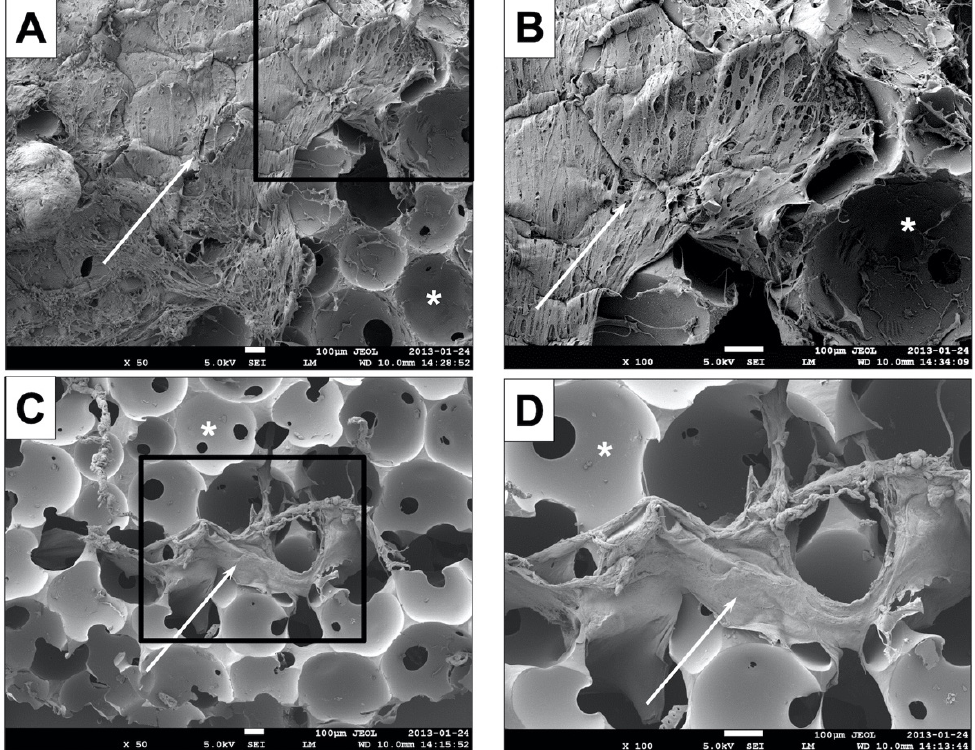
Figure 6. Scanning electron microscopy (SEM): The SEM shows that the cell-seeded fibrin hydrogel did not permeate the centre of the polyurethane foam. While the surface of the construct and the pores of the outer part of the PU foam were subtotally covered with the fibrin hydrogel (arrows) (( A , B ), which is an enlarged detail of ( A )), the centre (( C , D ), which is an enlarged detail of ( C )) was almost completely empty. Pores of the polyurethane foam are highlighted with asterisks. The scale bar of each pattern represents 100 μ m.